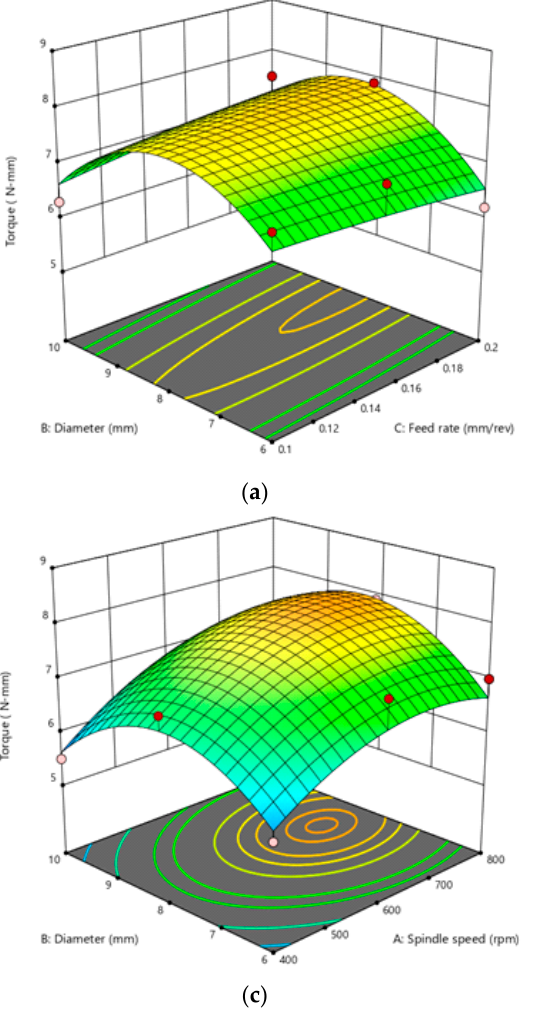
Figure 14. The 3D surface maps of the variables controlling torque. ( a ) Diameter and feed rate interaction. ( b ) Feed rate and spindle speed interaction. ( c ) Spindle speed and diameter interaction. ( d ) Actual vs. predicted torque.